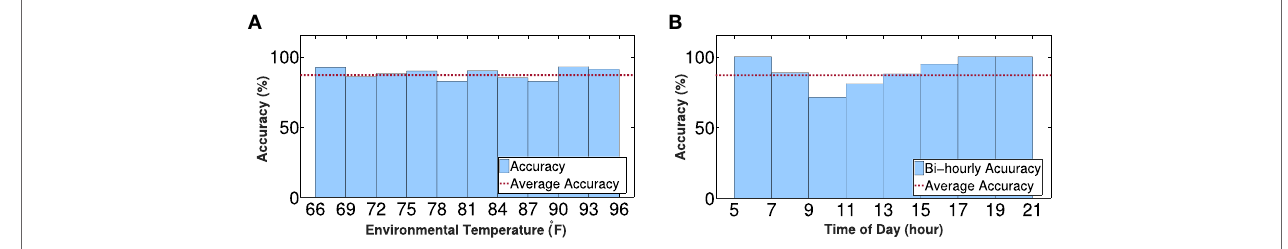
FIGURE 12 | Accuracy of train direction prediction (A) under different environmental temperatures between 66 and 96°F; (B) at different time of day from 5:00a.m. to 9:00p.m